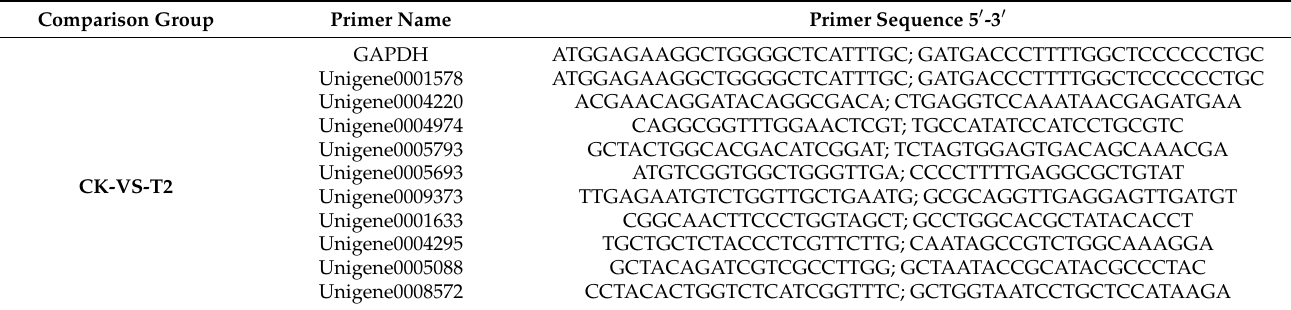
Table 2. Thirty Candidate validation genes and reference gene Primer pair